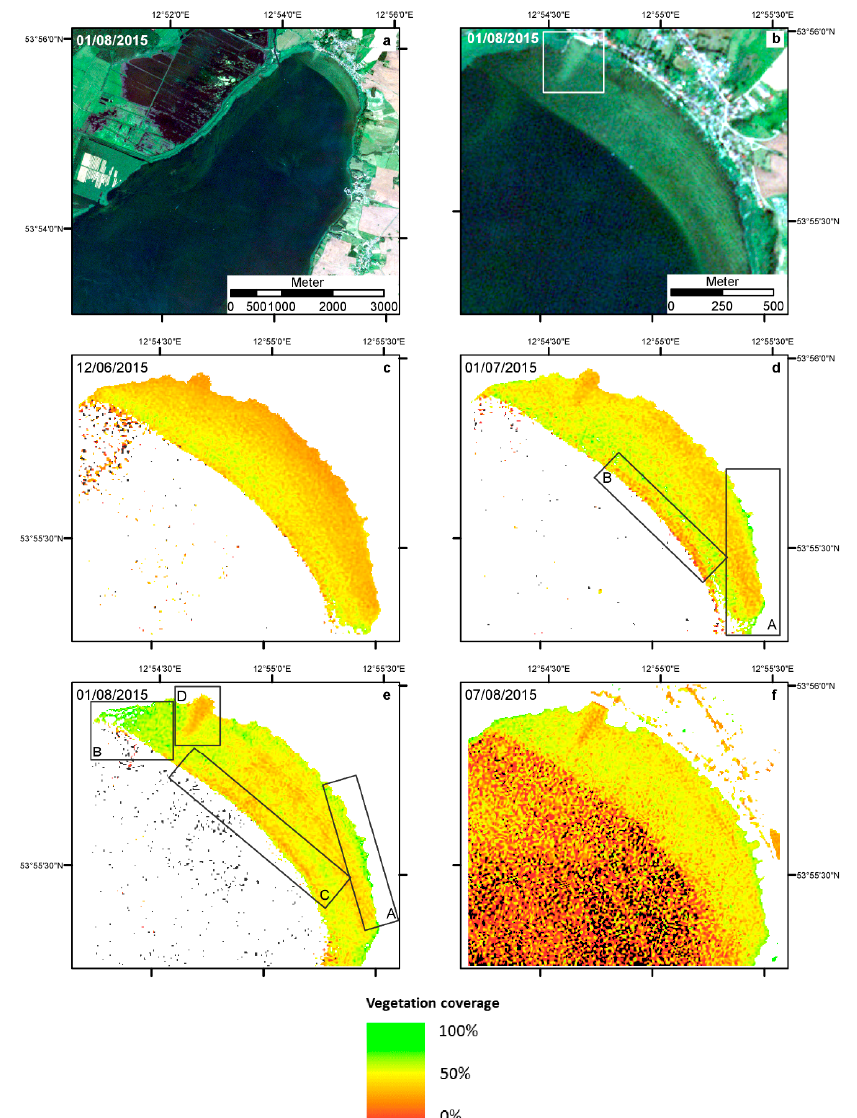
Figure 4. Seasonal changes in littoral bottom coverage of Lake Kummerow ( a ) northern littoral; ( b ) illustrated by the depth-invariant index Y 3,4 ; ( c ) 12 June 2015; ( d ) 1 July 2015; ( e ) 1 August 2015; ( f ) 7 August 2015. Bare sediment covered areas are displayed in red, dense SAV in green, mixed areas in yellow. Land and deep water areas are masked (except for 7 August 2015 where only land areas have been masked successfully), invalid pixels are displayed black. Contains material © (2015) Planet Labs. All rights reserved.